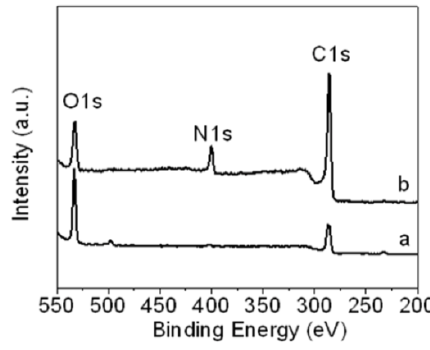
Figure 2. X-ray photoelectron spectroscopy (XPS) of ( a ) GO and ( b )